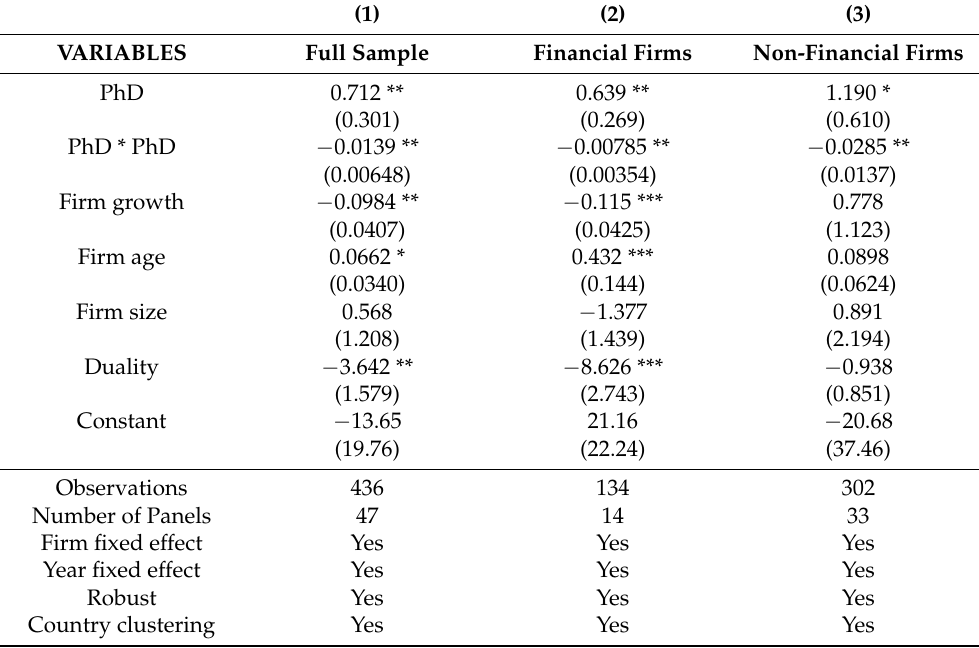
Table 5. The non-linear impact of holding PhD certificates on gender diversity in BOD.